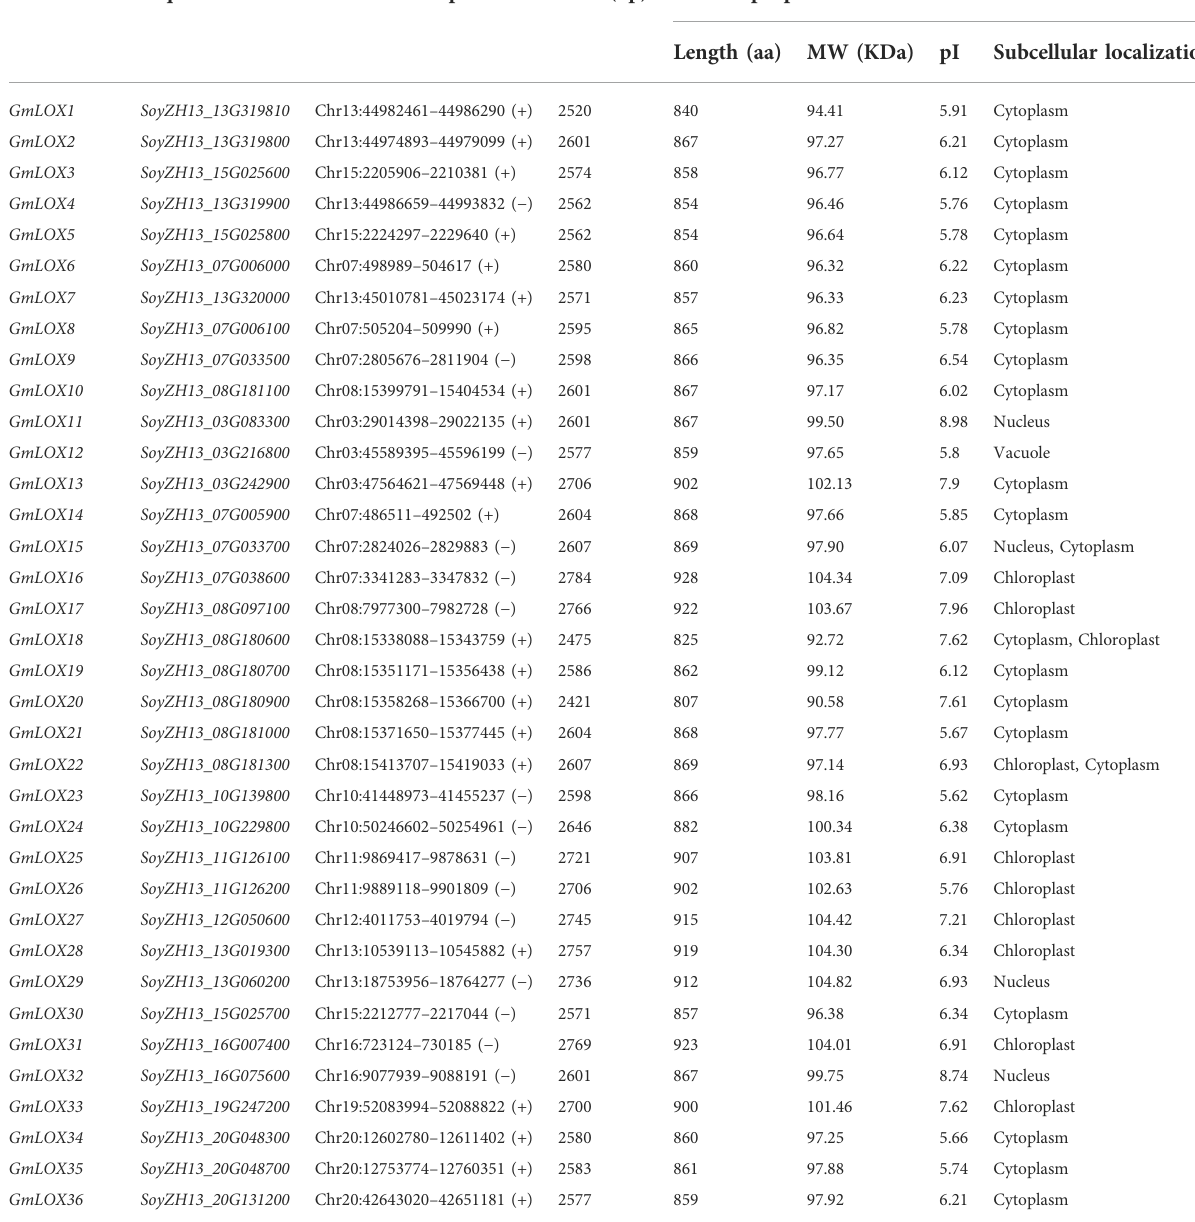
TABLE 1 The sequence characteristics of GmLOX in Zhonghuang